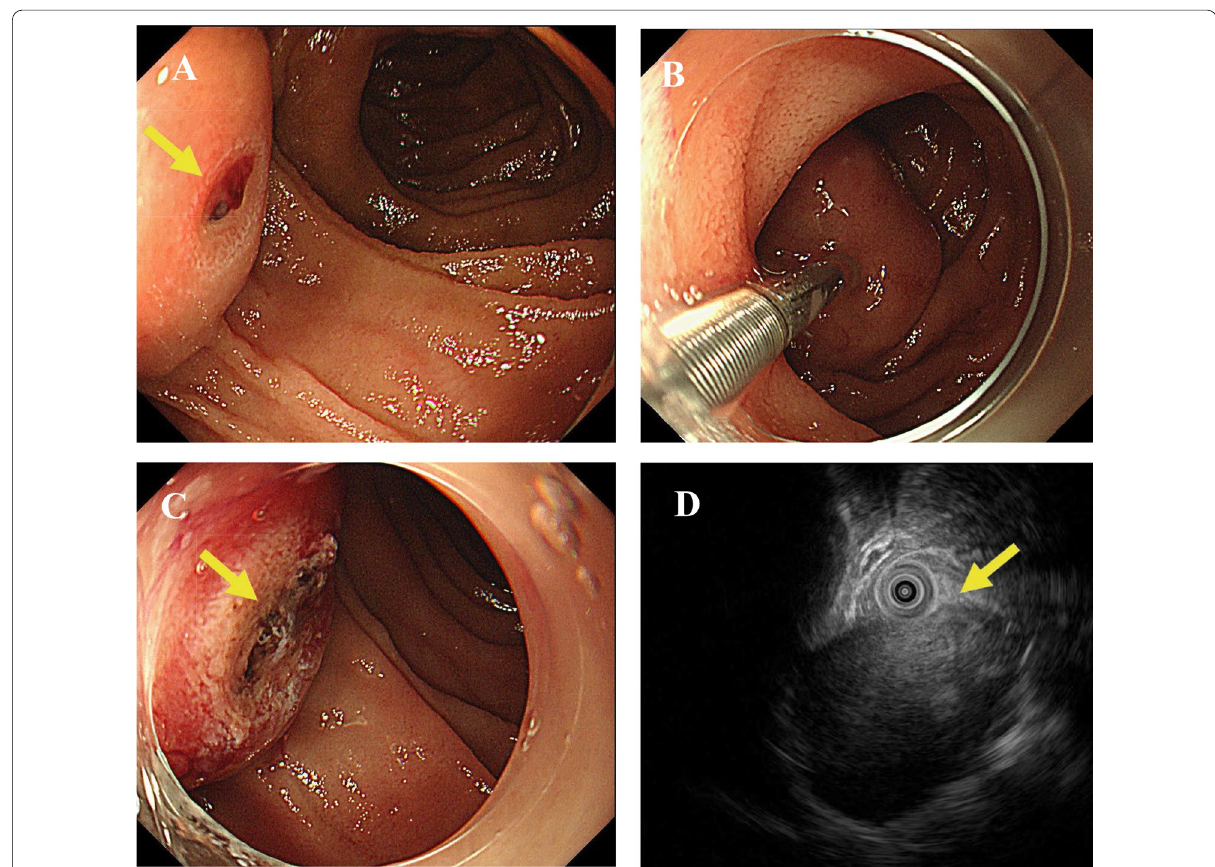
Fig. 2 A Esophagogastroduodenoscopy showed bleeding from the exposed blood vessels at the top of the 20-mm submucosal tumor in the second part of the duodenum (arrow). B , C The bleeding was successfully controlled with electrocoagulation (arrow). D